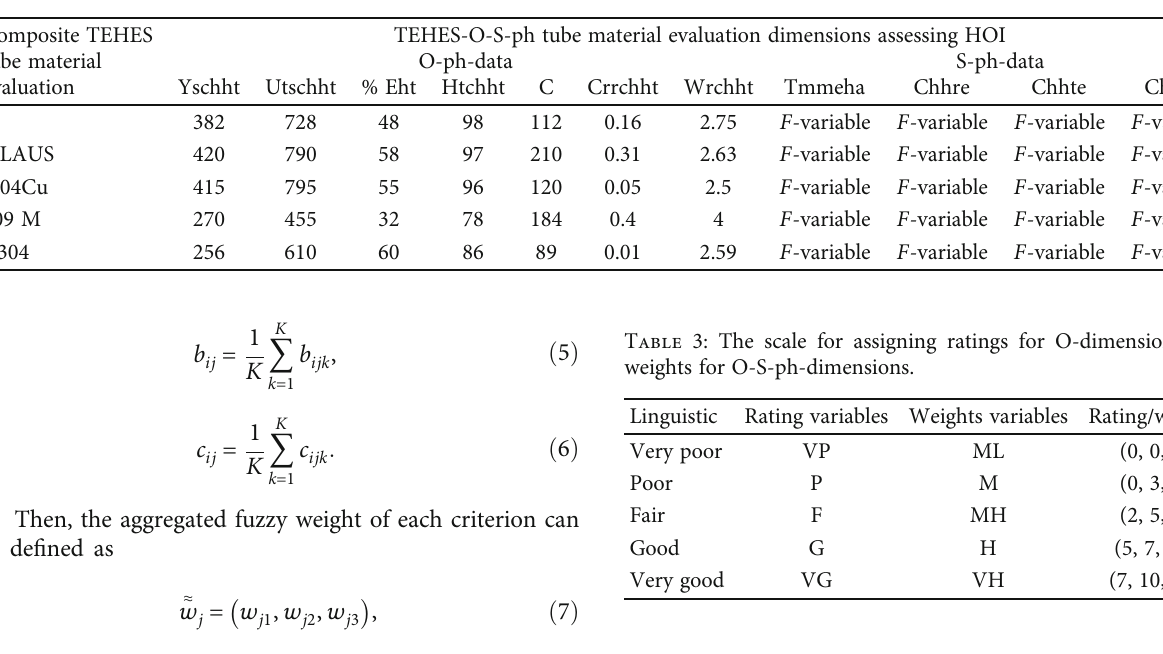
Table 2: TEHES-O-S-tube material dimensions.